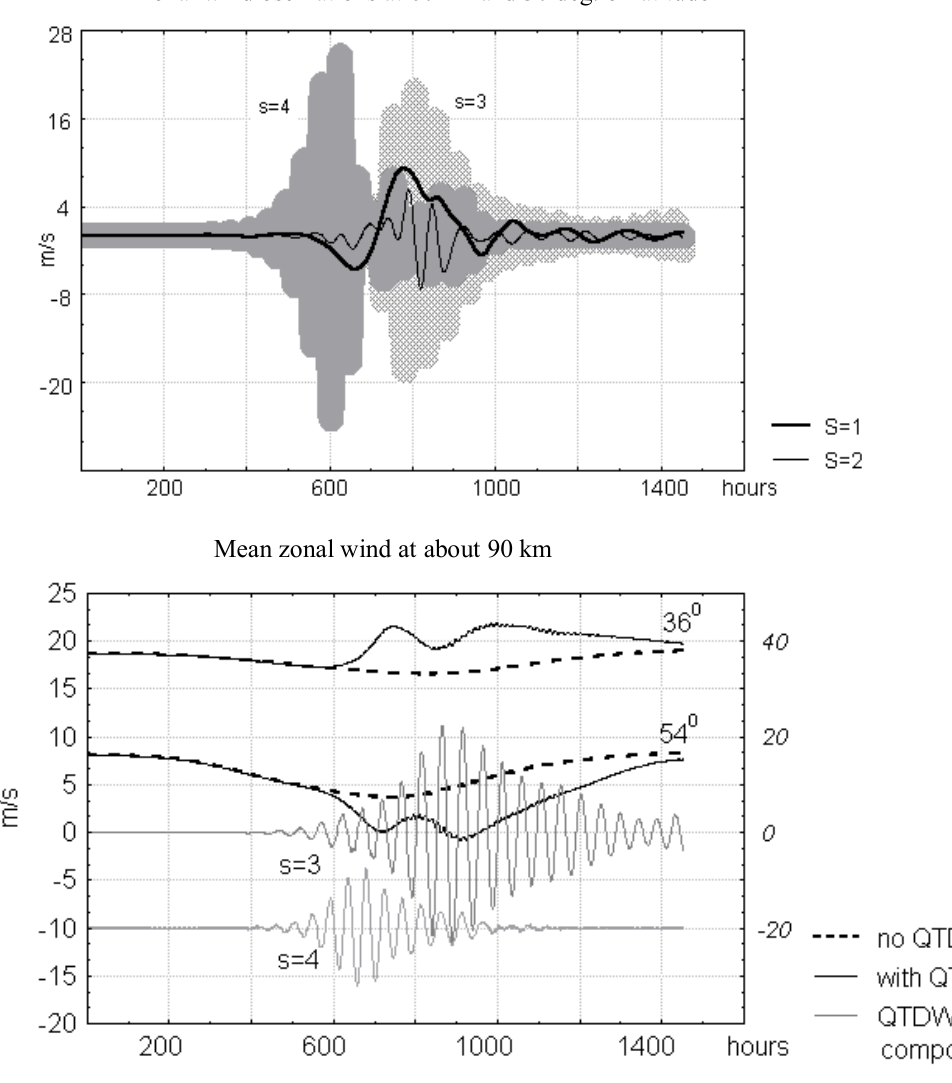
Fig. 6. (Top) Zonal wind oscillations for different zonal wave numbers near the region of jet instability. (Bottom) Mean zonal wind changing due to excitation and propagation of the 2-day wave. The zonal components of the QTDW at 54 ◦ (right axes) are added, the s=4 oscillations are